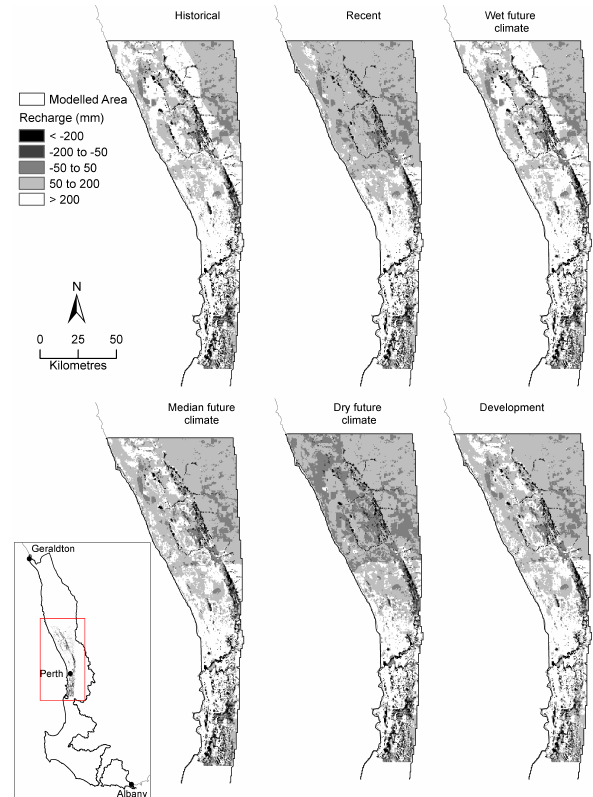
Fig. 2. Annual average recharge (mm) in the PRAMS model